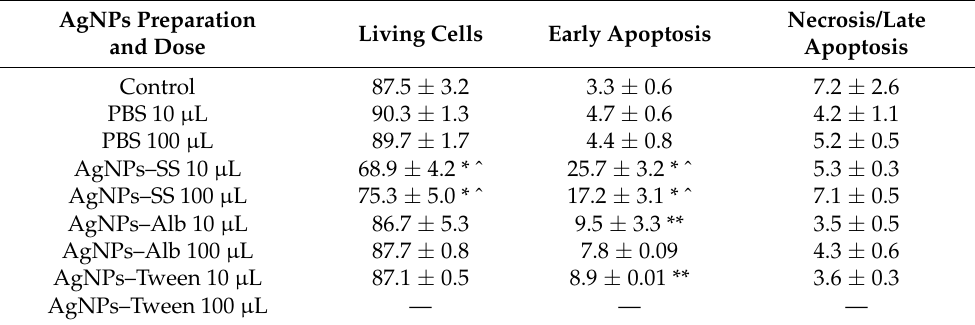
— — — — — — Data are expressed as mean ± SD. * p < 0.001 compared with control (LSD test); ** p < 0.05 compared with control (LSD test); ^ p < 0.001 compared with appropriate PBS volume.